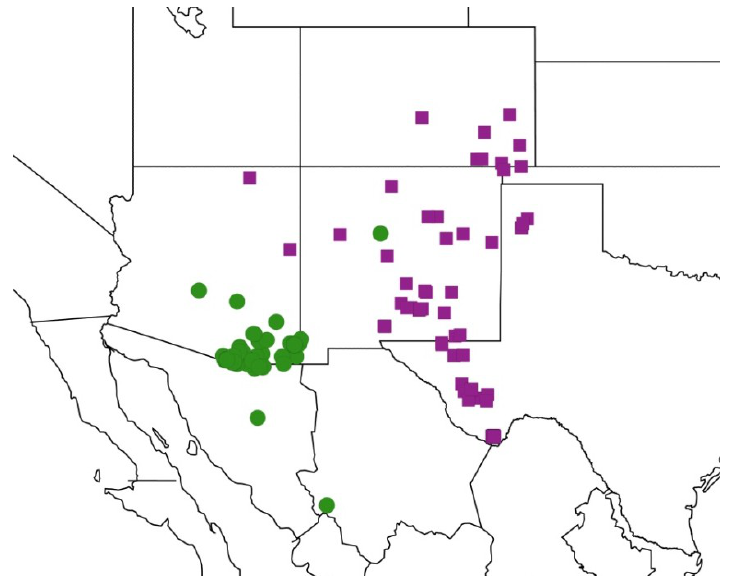
Figure 20. Distribution of Tibicen parallelus (green circles) and T. inauditus (purple